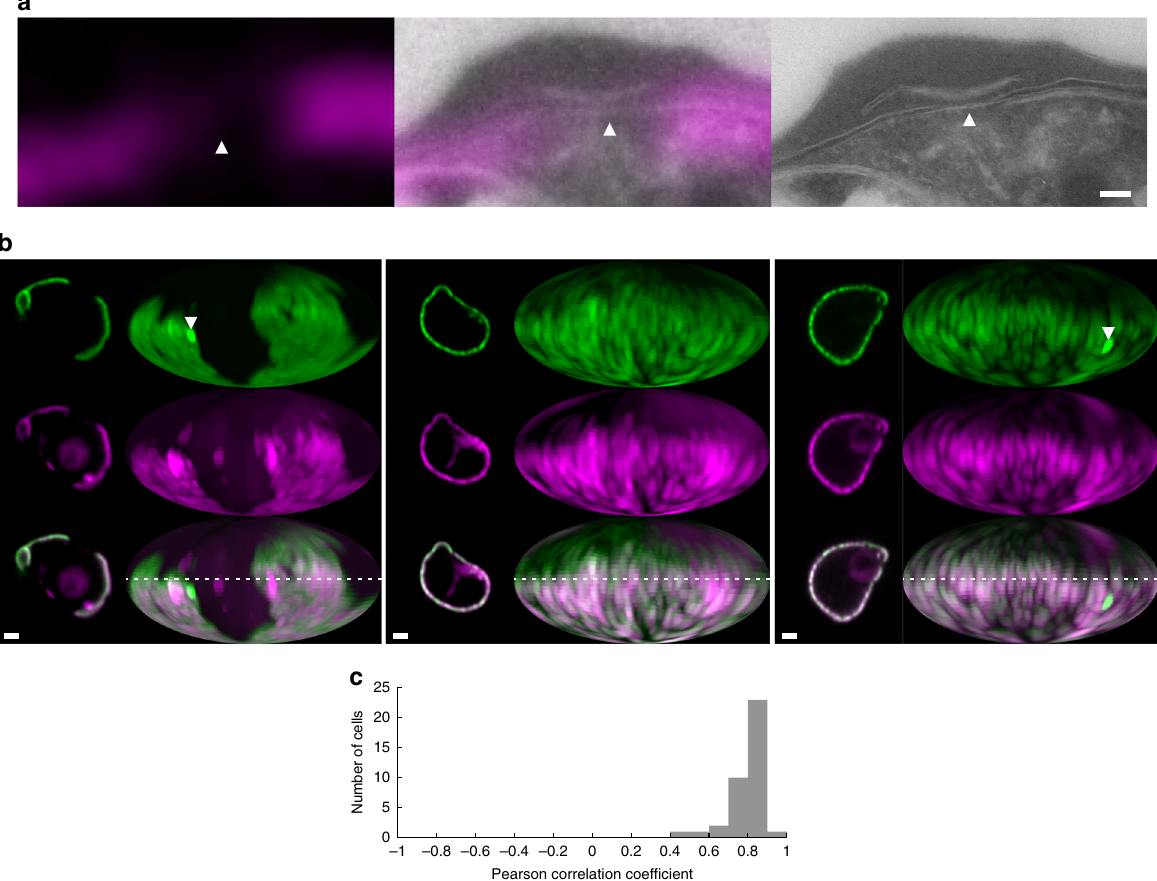
Fig. 3 Colocalization of vacuolar space with EXP2. a Detail of correlative light electron microscopy of EXP2-mNeonGreen — PV-mRuby3 parasites showing the presence of PV-mRuby3 in the PV lumen and absence in the apposed membrane region (arrowhead) (see Fig. SI 2 for the full image, more details and mNeonGreen channel). (magenta, left) mRuby3 signal in the Tokuyasu cryo-section. (middle) Overlay of confocal and electron microscopy image. (right) Higher resolution electron microscopy image of the region. Scale bar: 100 nm. b Center confocal slice and Mollweide projections of EXP2-mNeonGreen — PV-mRuby3 parasites. EXP2-mNeonGreen (green, top), PV-mRuby3 (magenta, middle), merge (bottom). Samples chosen represent examples of relatively low (0.76), average (0.80) and high (0.89) Pearson correlation coef fi cients of the maps. White arrowheads show tubulovesicular network 51 that has a relatively higher density of EXP2. Scale bars: 1 µ m. The dotted line labels the equator, corresponds to the confocal slice. c Histogram of Pearson correlation coef fi cients of trophozoite stage EXP2-mNeonGreen — PV-mRuby3 parasites ( N = 38 cells). Regions that extend from the parasite to form the tubulovesicular network were excluded for the correlation analysis. Source data are provided as a Source data fi